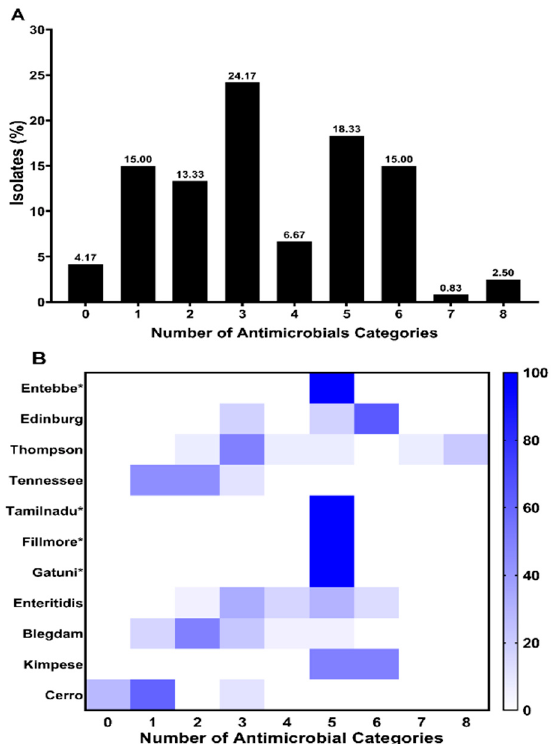
Figure 2. Distribution of multidrug resistance (MDR) strains. ( A ) Prevalence of antimicrobial-resistant strains according to the number of antimicrobial classes; ( B ) serovar distribution of MDR prevalence. The X-axis represents the number of antimicrobial categories. The color of individual cells varies with the percentage of antimicrobial resistance shown in the cells. * serovar containing only one strain.